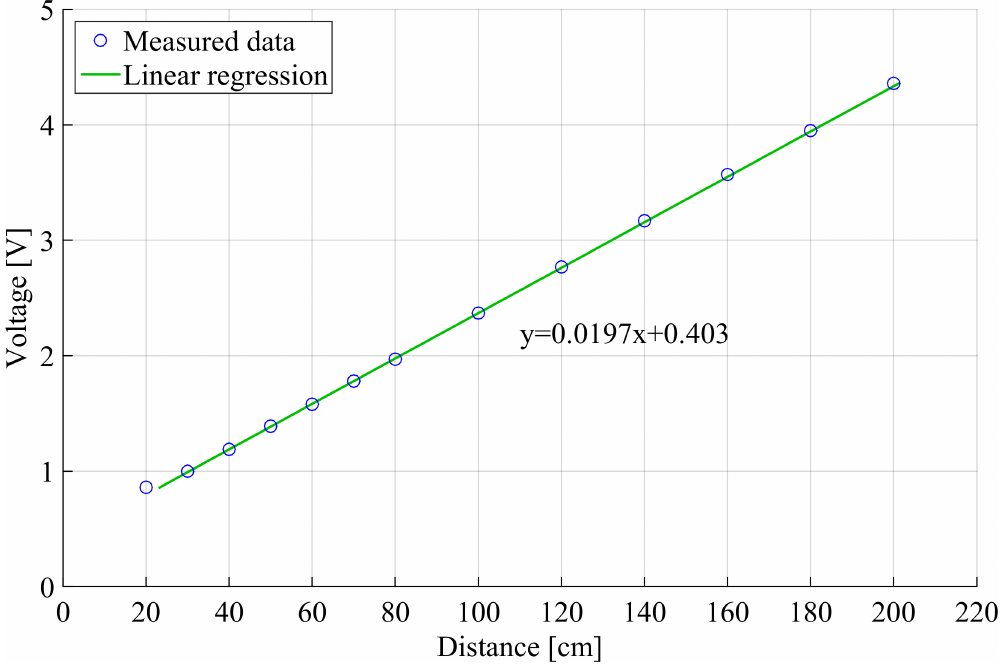
Figure 5. Calibration of the laser sensor. By inverting the linear regression equation, Equation (4) is